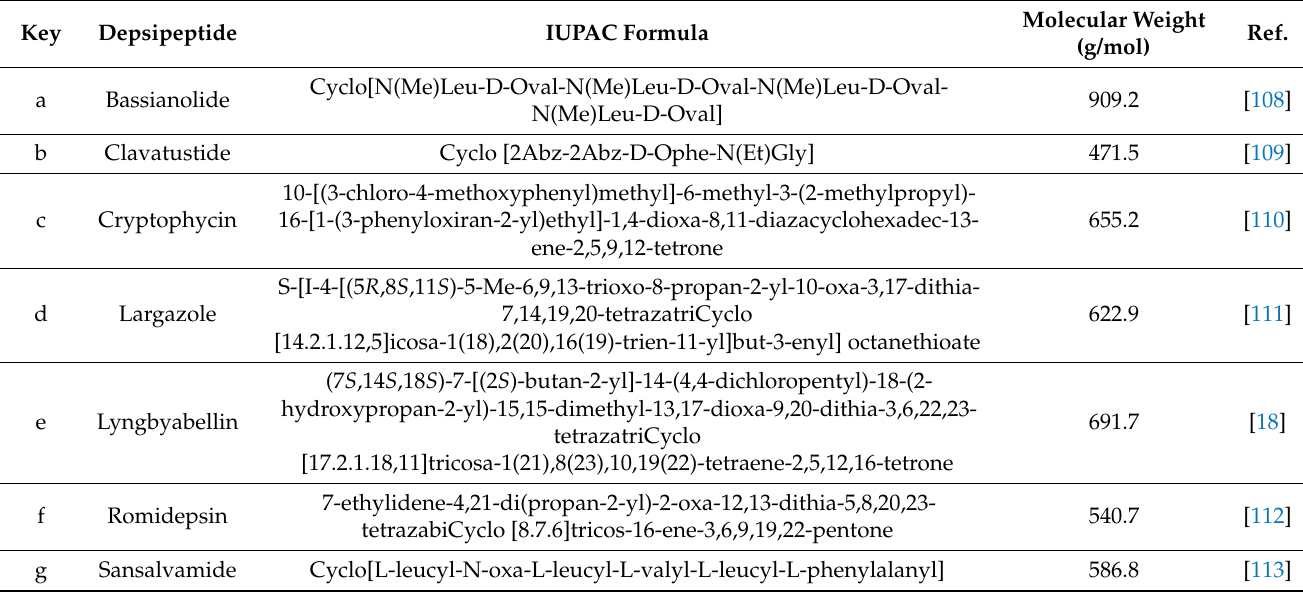
Table 4. Formula and molecular weight of depsipeptides inhibiting histone deacetylases in tumor